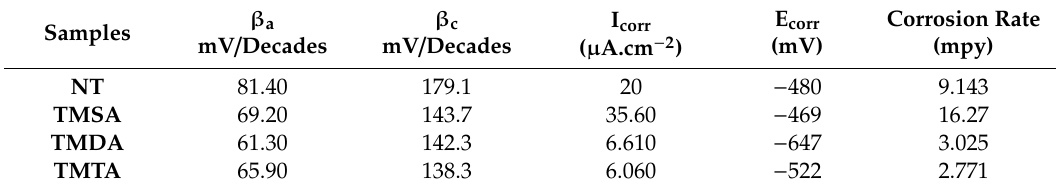
Figure 7. Tafel scans of non-treated and TMCA treated experimental AISI 1345 steel. Table 2. Kinetic parameters of non-treated and TMCA treated AISI 1345